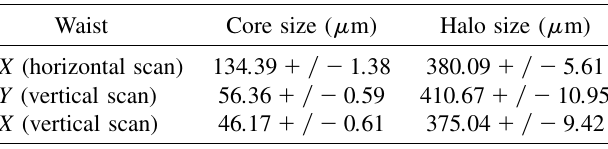
TABLE IV. The rms core size and halo size from double Gaussian fits to line scans of beam images taken at X and Y beam waists.